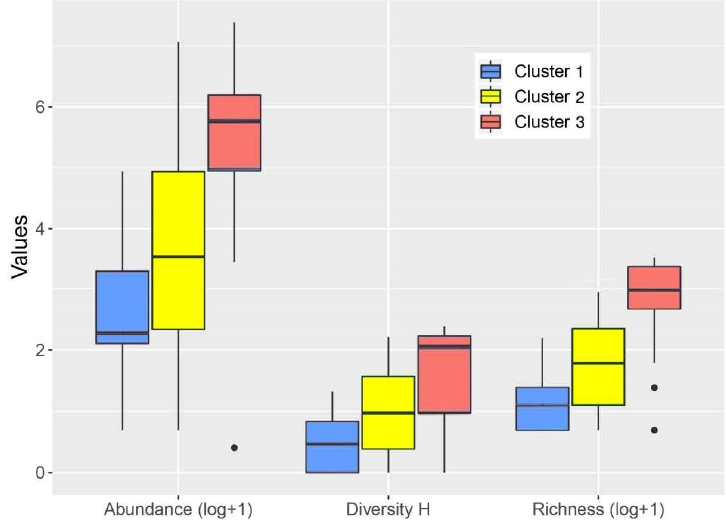
Figure 2. Box-and-whisker plots of values for taxonomic abundance (TA), and taxonomic richness (TR) and Shannon–Wiener’s diversity (H) of mollusc assemblages in each cluster. Rectangles delineate the first and third quartiles, dark bars are the medians, and the dots are outliers.